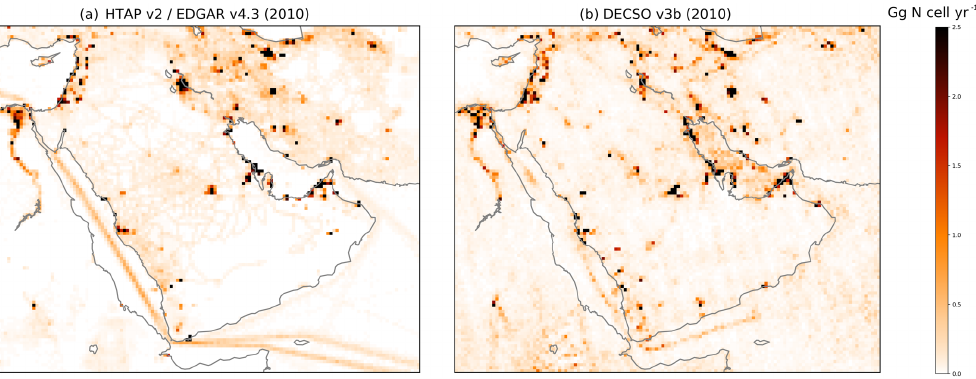
Figure 5. NO x emissions in the Middle East in 2010 derived from (a) the bottom-up inventory EDGAR v4.3 and (b) the DECSO algorithm v3b applied to OMI NO 2